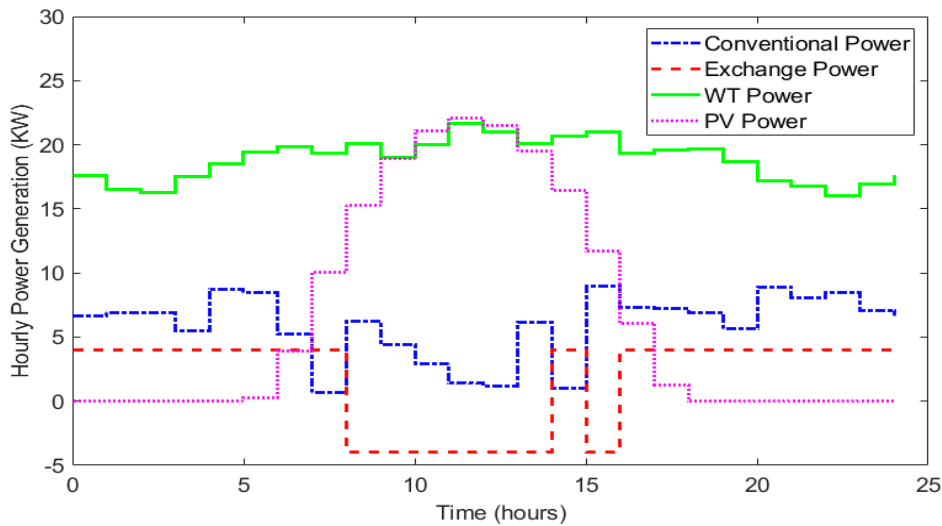
Figure 14. Total hourly power generation of all sources.